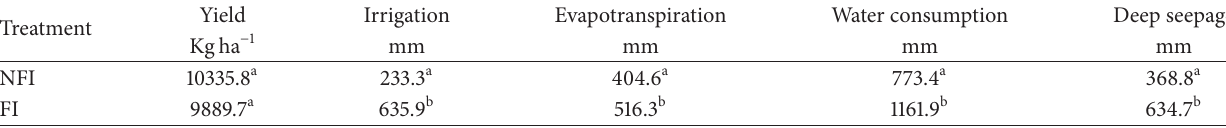
Table 2: Rice yields and water consumption under different irrigation managements.